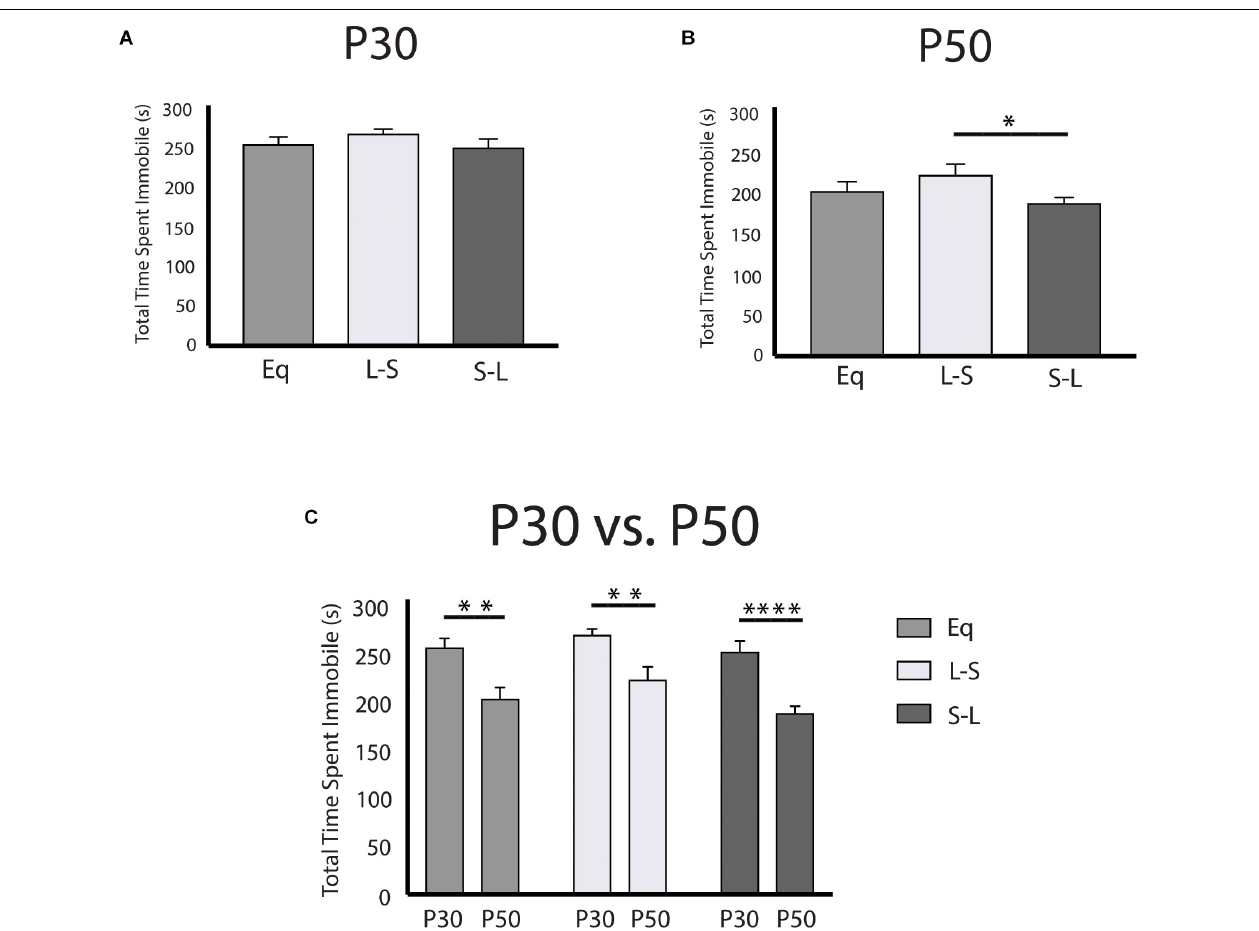
FIGURE 5 | Postnatal Long photoperiod reduces depressive-like behavior in adulthood utilizing the tail suspension test. (A) Analysis of total time spent immobile across photoperiods at P30, (B) at P50, and (C) within photoperiods during the P30 and P50 time points. The significance levels are as follows: ( ∗ p < 0.05, ∗∗ p < 0.01, ∗∗∗∗ p < 0.0001) using Holm-Sidak’s multiple comparison